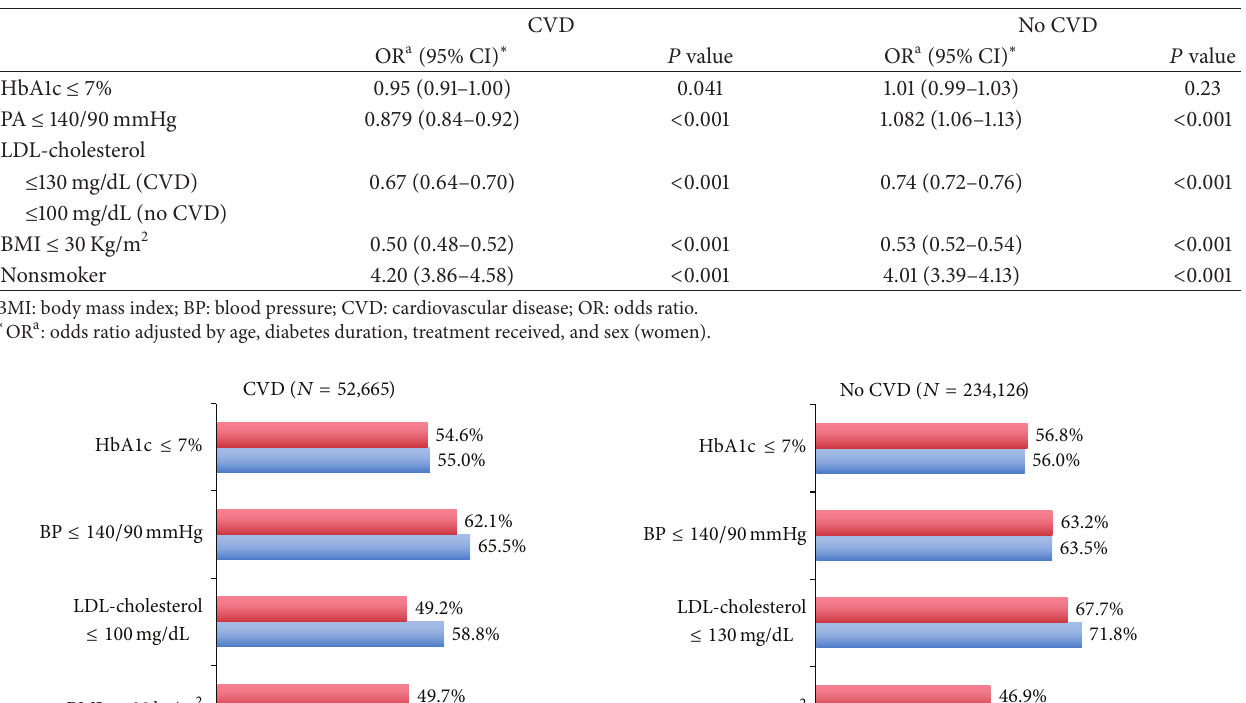
Table 2: Multivariate analysis on the degree of control of CVRFs stratified according to the presence of CVD.